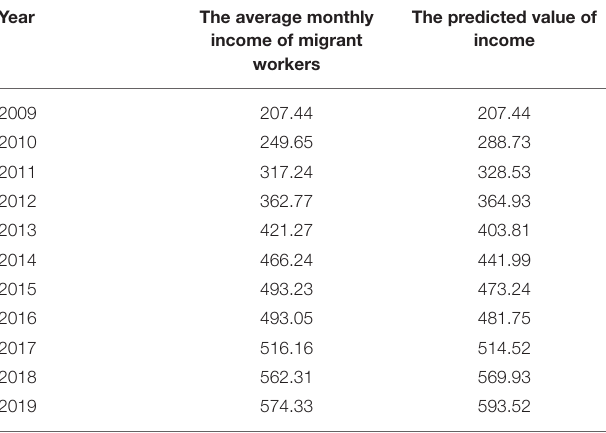
TABLE 4 | The average monthly income of migrant workers (dollar).